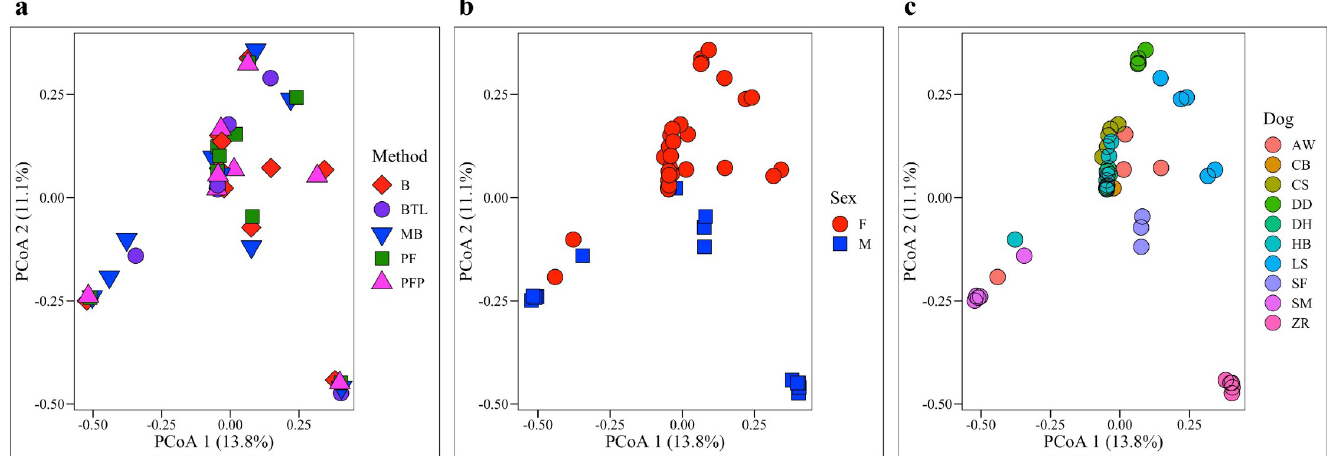
Fig 4. Bacterial composition. Bray Curtis dissimilarity matrices were used to compare bacterial composition (beta-diversity) by ( a ) extraction method, ( b ) sex, ( c ) and dog. Bacterial composition did not differ significantly by method (PERMANOVA, p = 1.000) but did differ significantly by sex (PERMANOVA, p = < 0.001) and dog (PERMANOVA, p = <